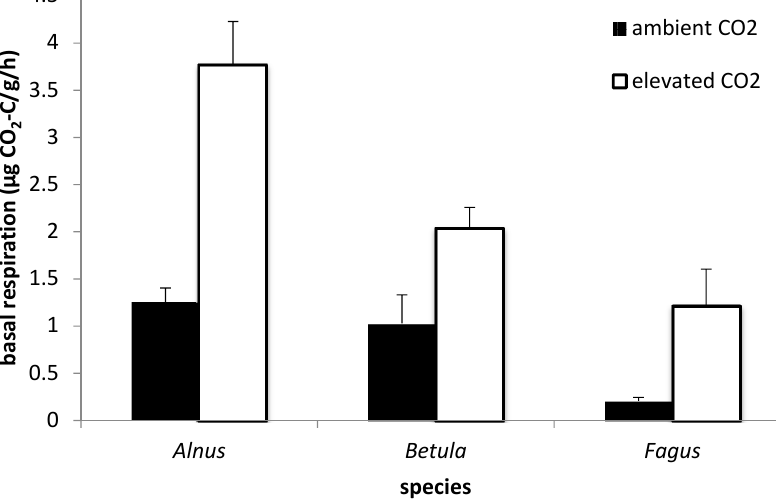
differ significantly ( p <0.05).